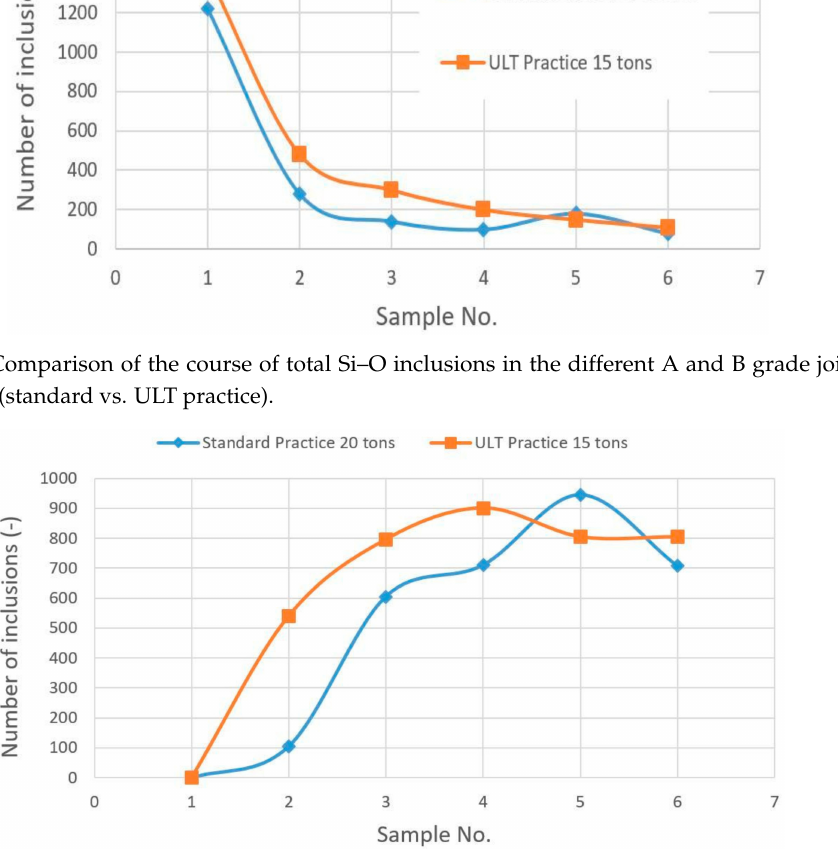
Figure 7. Comparison of the course of total Al–Ca–O inclusions in the different A and B grade joining conditions (standard vs. ULT